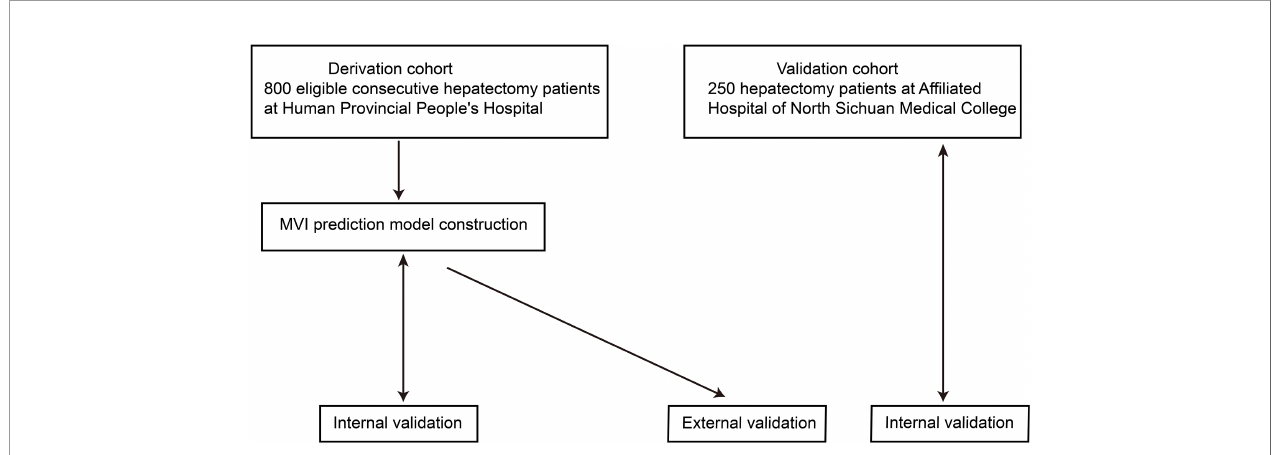
FIGURE 1 | Flow chart overview of the study. The derivation and validation cohorts were gathered during the periods of January 2015 – September 2019 and January 2018 – September 2019, respectively. Internal validation was conducted with the bootstrap method (2000 samples drawn from 75% of the original